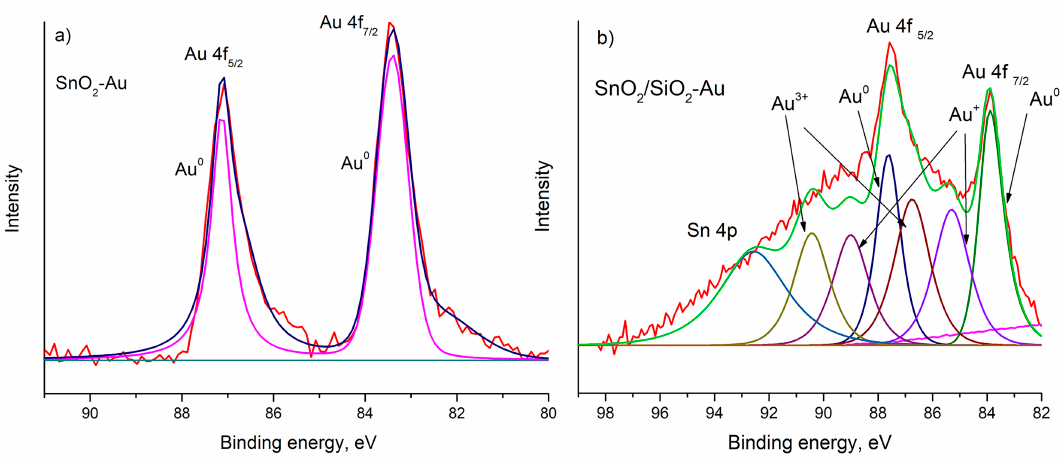
Figure 6. Au-component XP-spectra of: ( a ) SnO 2- Au and ( b ) SnO 2 / SiO 2